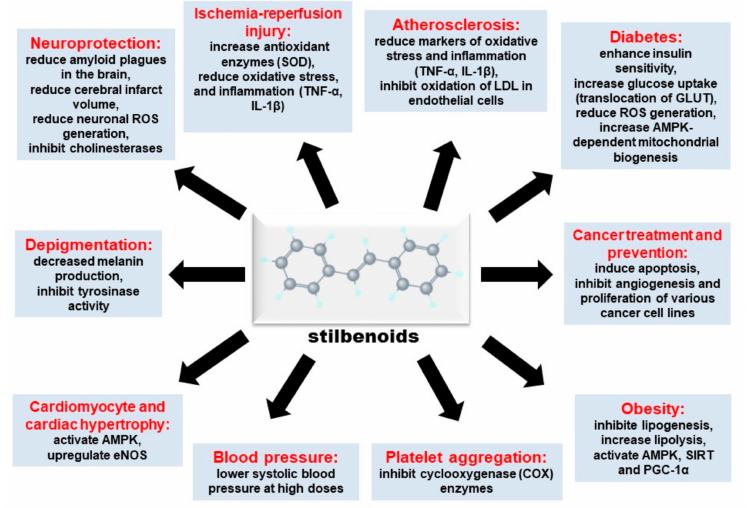
Figure 2. Summary of mechanisms of biological activities of